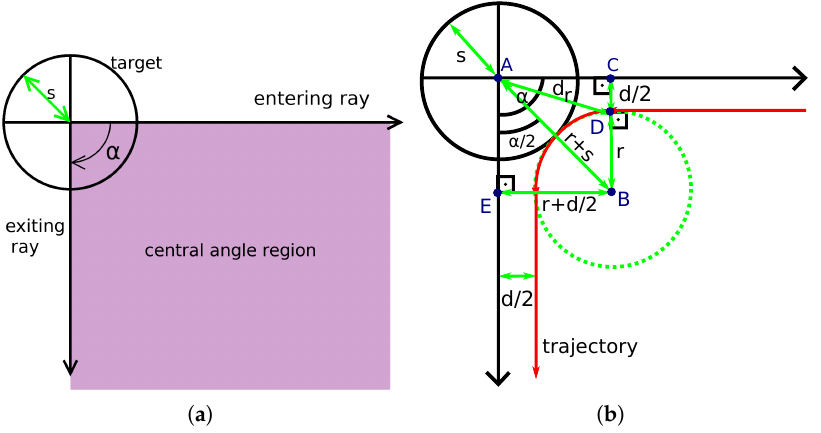
Figure 12. Illustration of the touch and run strategy. ( a ) Central angle region and its exiting and entering rays defined by the angle α . ( b ) Trajectory of a robot next to the target in